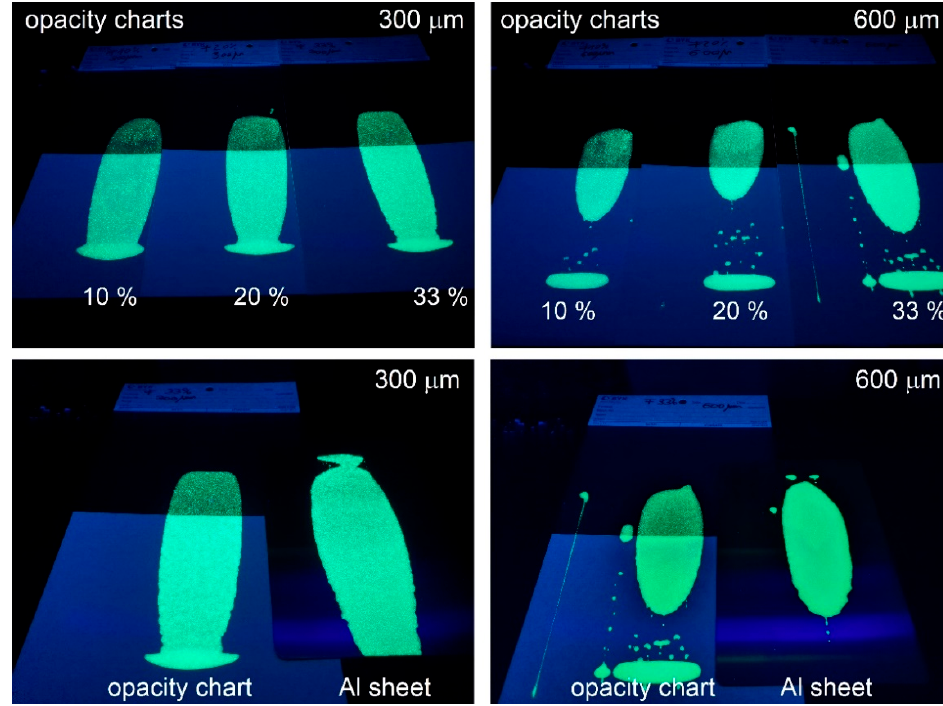
Figure 12. Images of the applied coatings under the 365 nm UV irradiation.